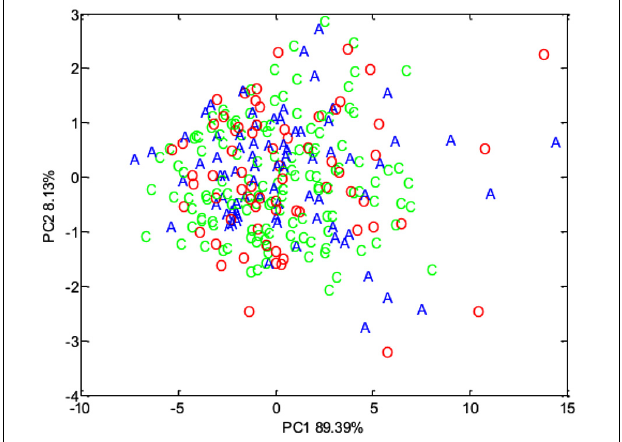
FIGURE 3 | Principal component analysis (PCA) plot summarizing fecal metabolome data derived from the host phenotypic groups: Aged (A) ( n = 11), Control (C) ( n = 12), and Obese (O) ( n =